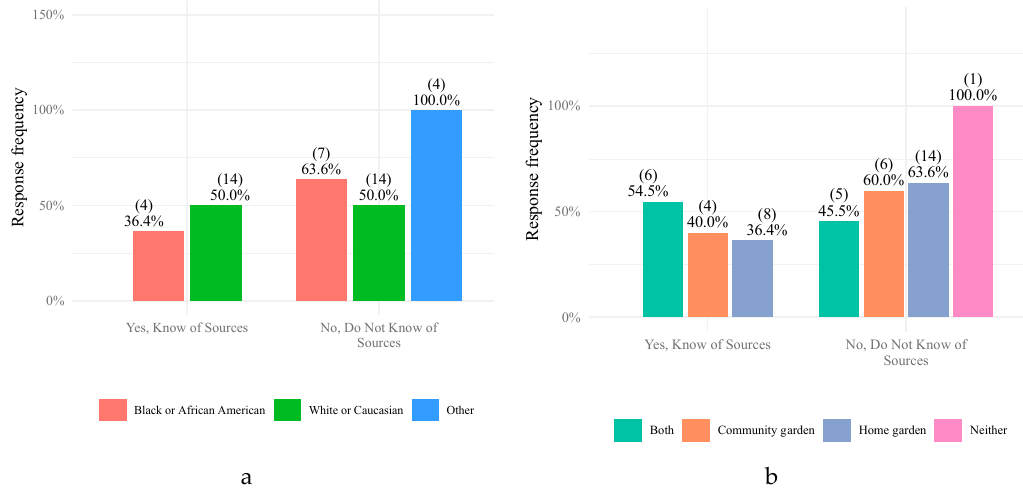
Figure 3. Knowledge of participants regarding potential sources of exposure to soil contaminants based on race ( a ) and type of garden ( b ).